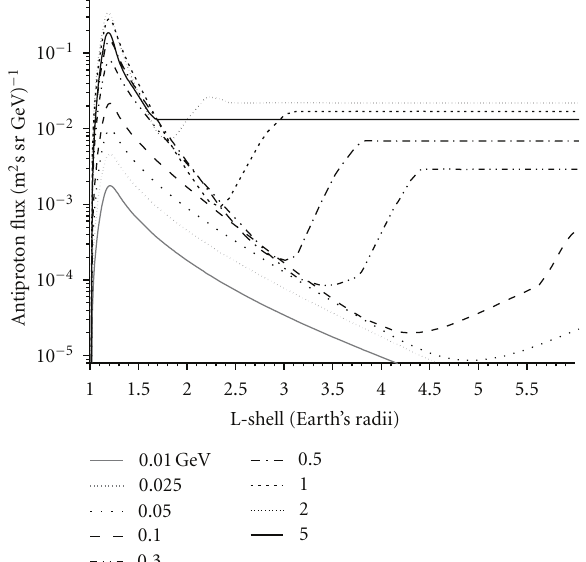
Figure 7: The L -dependence of the trapped antiproton fluxes spectra in the Earth’s magnetosphere from the CRA ˜ND source for various energies.